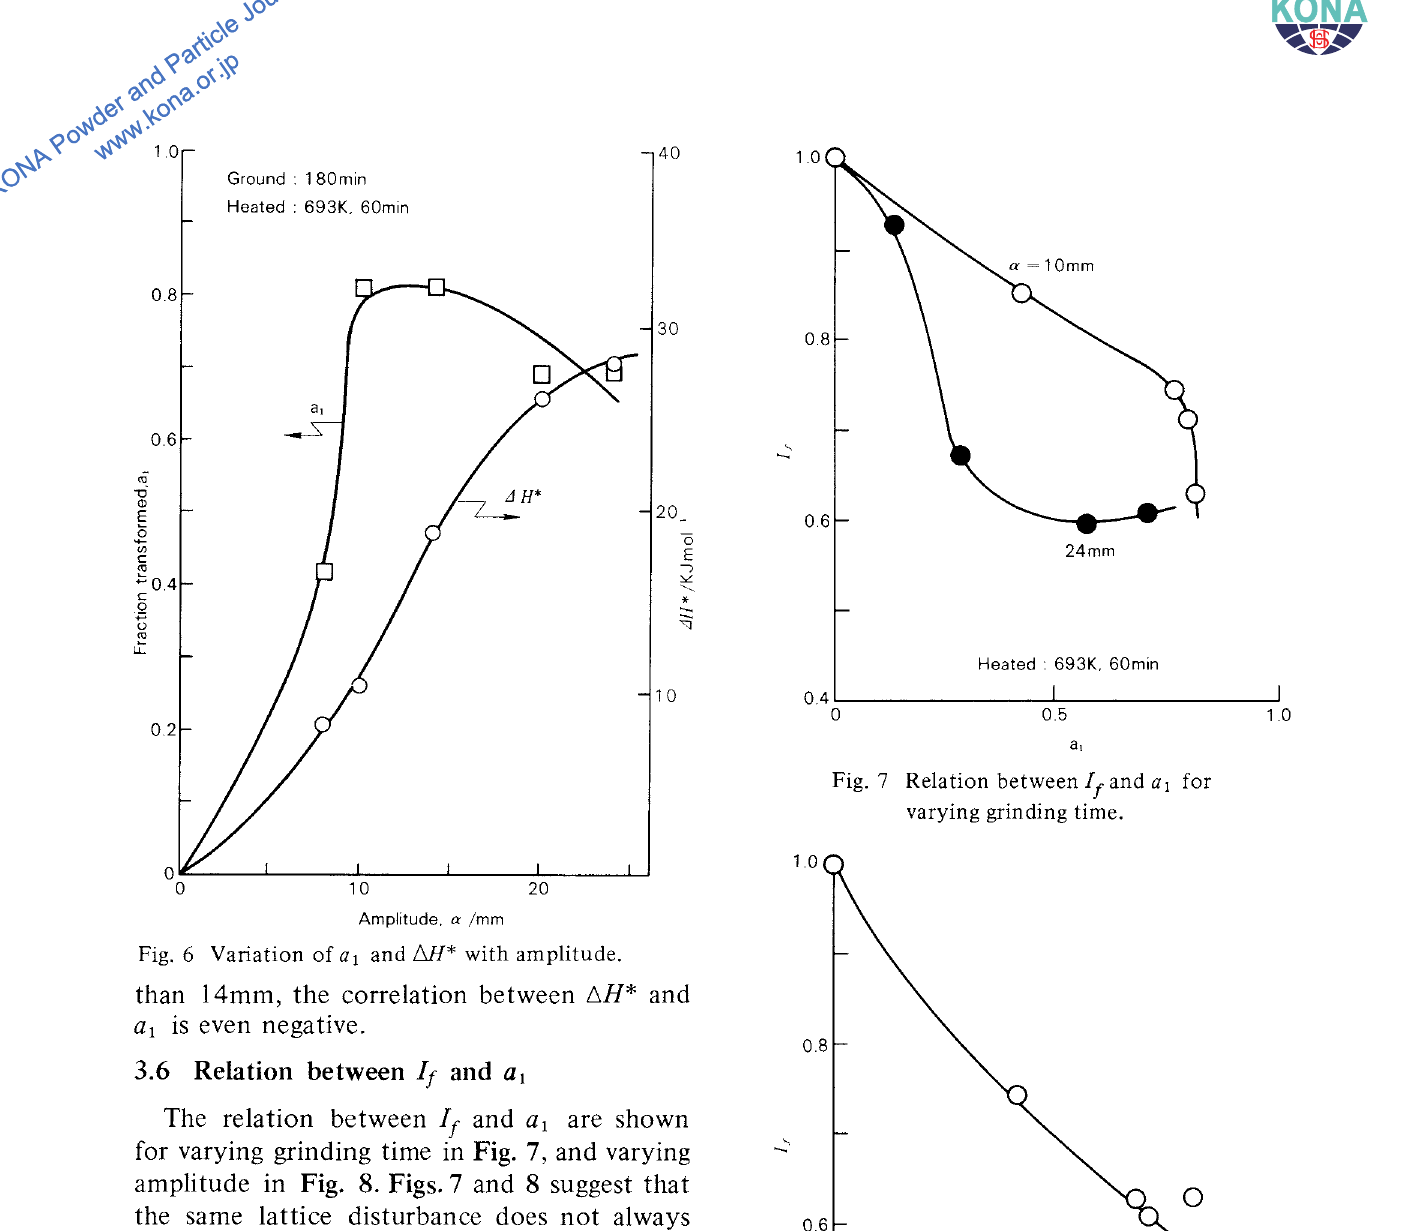
Fig. 8 Relation between If and a 1 for varying